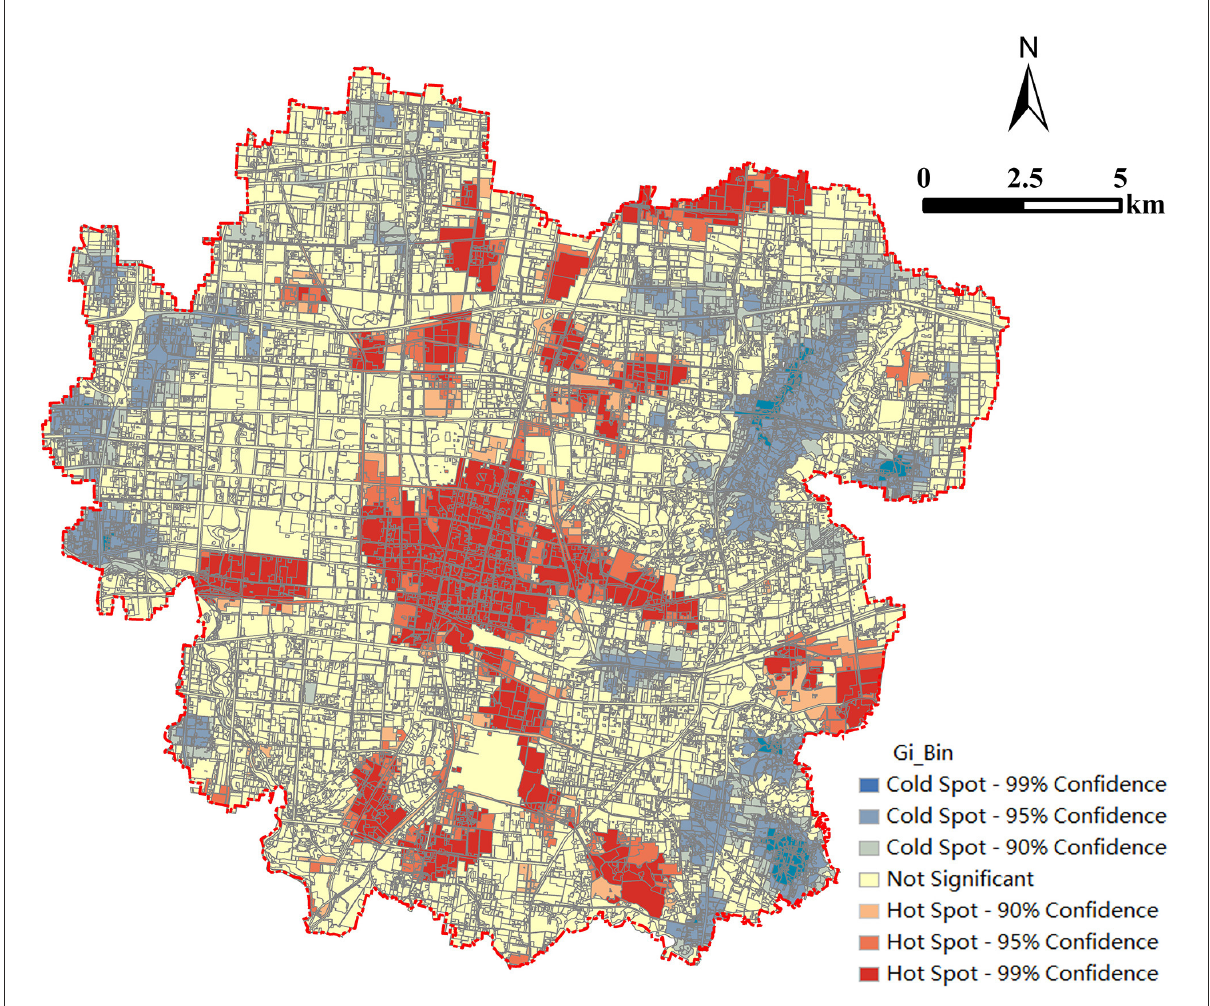
FIGURE6 The Getis-Ord Gi* statistics of land patch level carbon emissions.